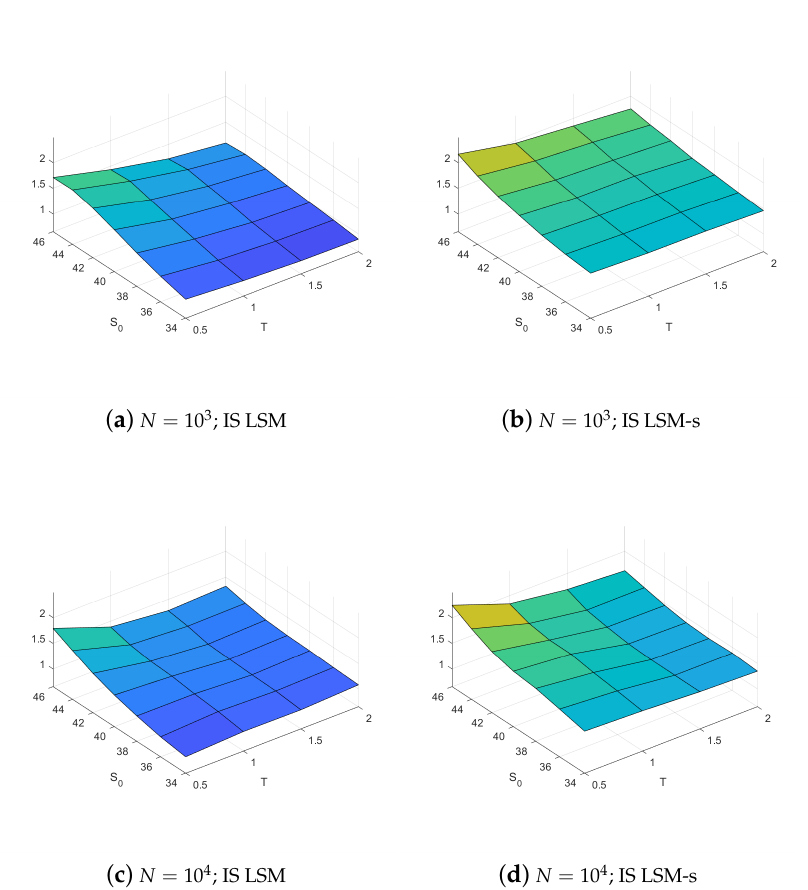
Figure 4. RMSE efficiency with optimal drift. RMSE efficiency results are calculated from a sample of R = 10 7 / N replications of the LSM and the LSM-s estimators. The left column illustrates results for the LSM without importance sampling, the center column LSM with importance sampling, and the right column LSM-s with importance sampling. The top row presents results for estimators using 1000 paths and the bottom row for 10,000